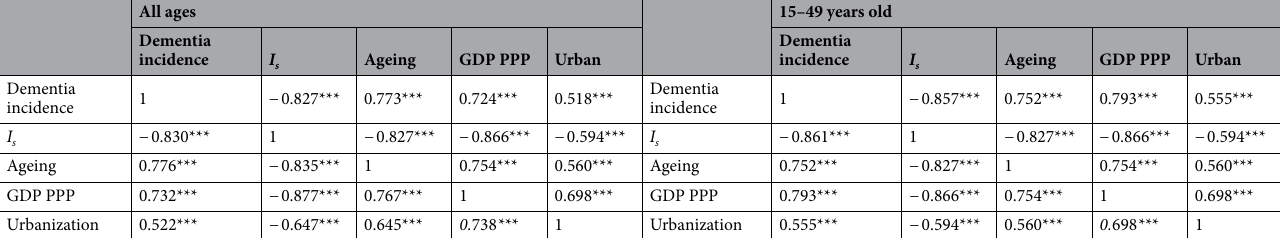
Table 1. Pearson’s r (above the diagonal) and Spearman’s rho (below the diagonal) between the opportunity for selection ( I s ) and dementia incidence. Significance level: * p < 0.05; ** p < 0.01; *** p < 0.001; Sample size range: 175–204. Data sources: Dementia Incidence expressed as the number of new onsets of Alzheimer’s disease and other dementias published by the Institute for Health Metrics and Evaluation (IHME) in 2020; I s measuring the magnitude of the opportunity for natural selection, extracted from the previous publication by You et al. https:// doi. org/ 10. 1111/ eva. 12523; Ageing expressed with life expectancy at 65 years old (2010–2015) published by the United Nations; GDP PPP expressed in purchasing power parity in 2015 US dollars published by the World Bank; Urbanization expressed in percent of population living in urban areas in 2015 published by the World Bank.